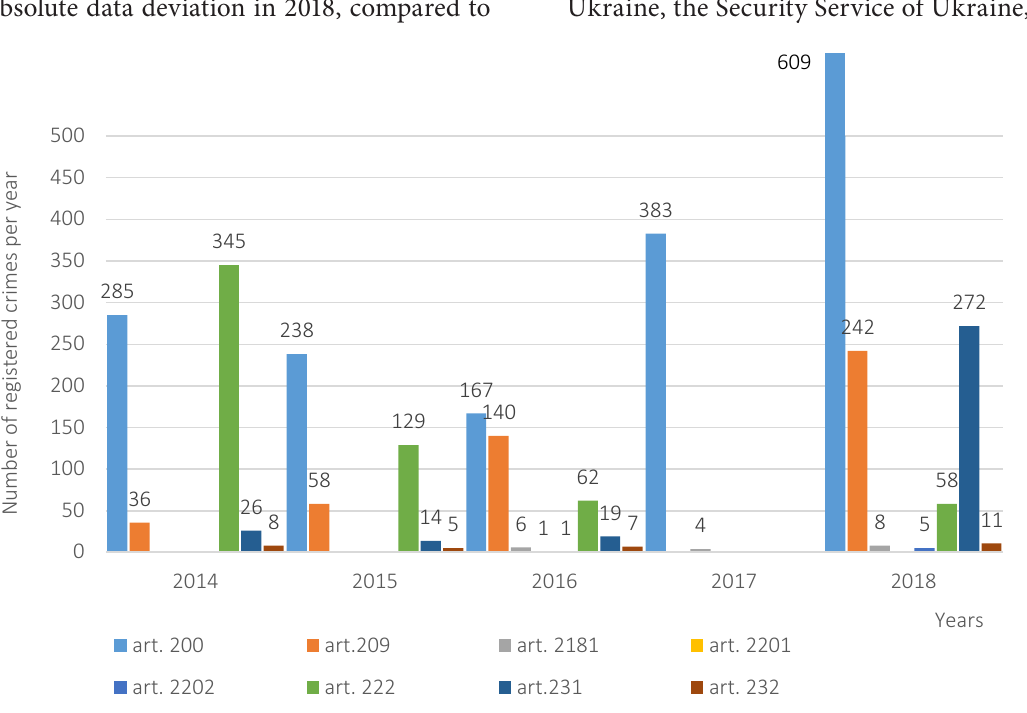
Figure 1. Banking crime statistics in Ukraine for the period of